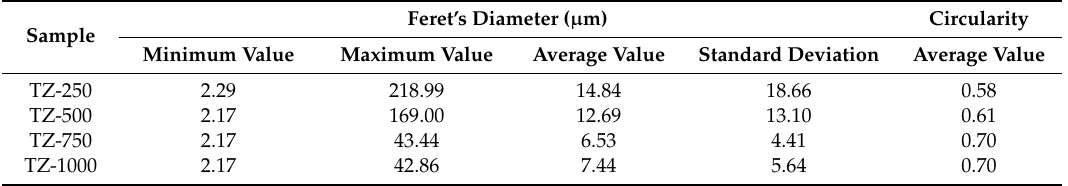
Figure 6. Graphs describing parameters of porosity: percentage of pores in the surface area section within the pre-defined ranges for all samples ( a ) and percentage of pores ( b ) in the sample after pressing with di ff erent pressures. Table 2. Results of the Feret’s diameter and circularity of the pores for the samples manufactured under di ff erent pressure